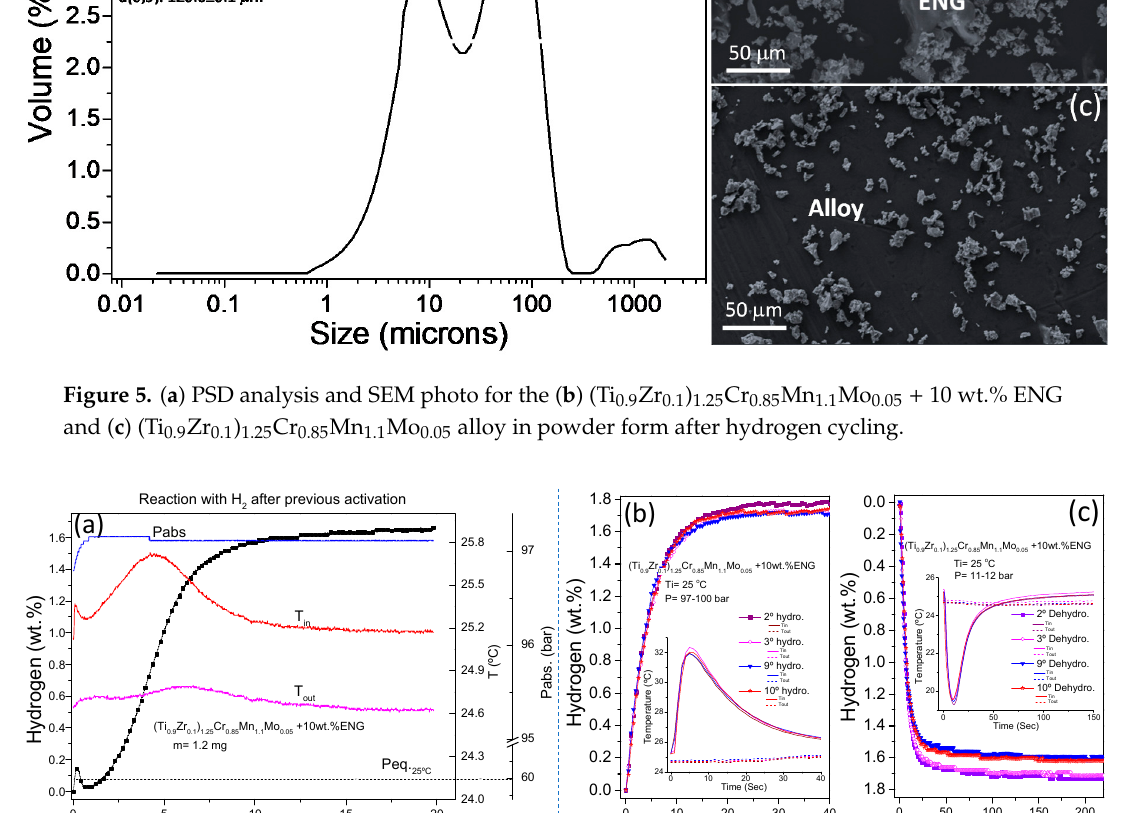
Figure 7. Hydrogen capacity upon cycling for (Ti 0.9 Zr 0.1 ) 1.25 Cr 0.85 Mn 1.1 Mo 0.05 + 10 wt.% ENG after activation. Values of dehydrogenation capacity (m = 300 mg, Sieverts apparatus [62]).